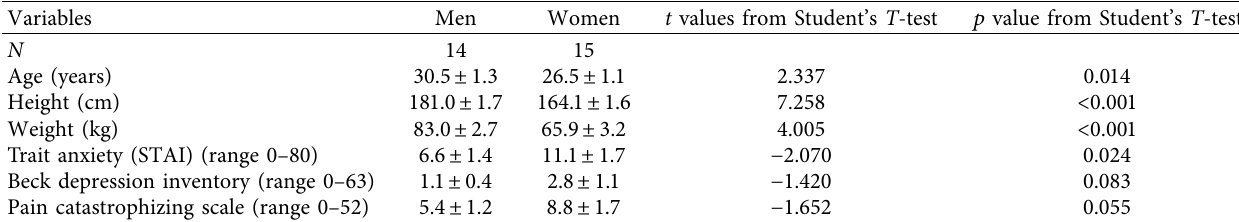
Table 1: Physiological and psychological characteristics of the